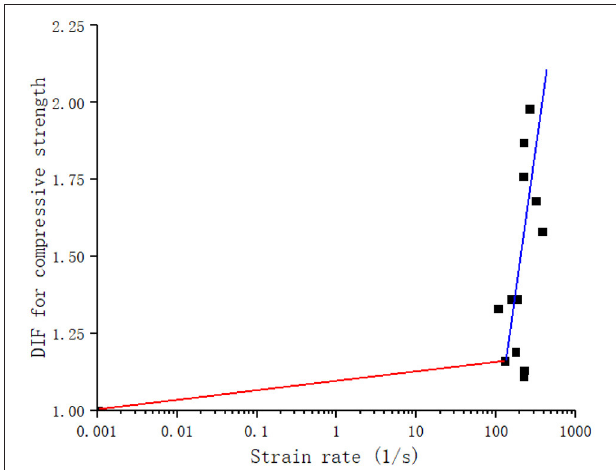
FIGURE 6 | Compressive DIF of BFRAAC with respect to strain rate.